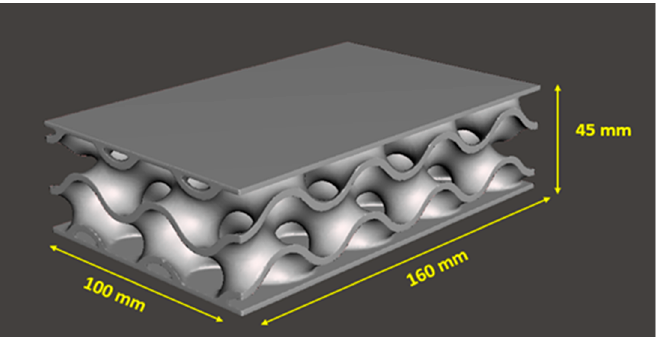
Figure 1. Illustrating the gyroid bridge bearing model from CAD software.